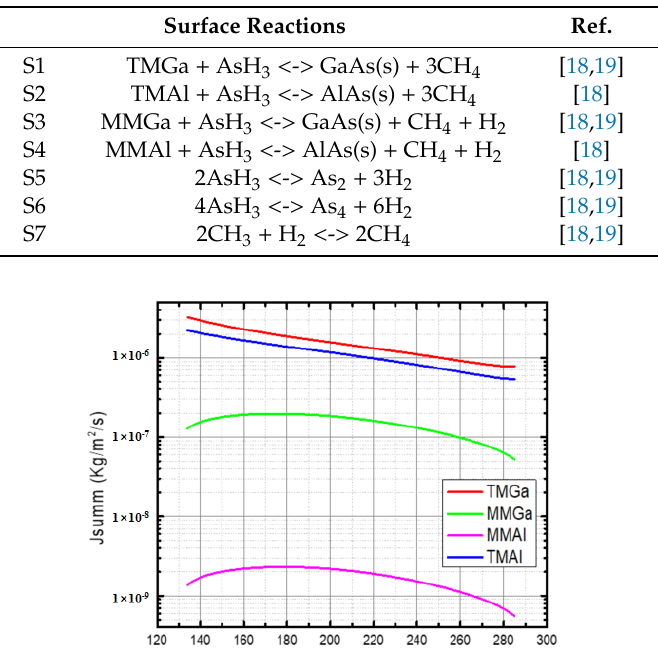
Table 3. Surface (S) reaction pathways for AlGaAs growth.